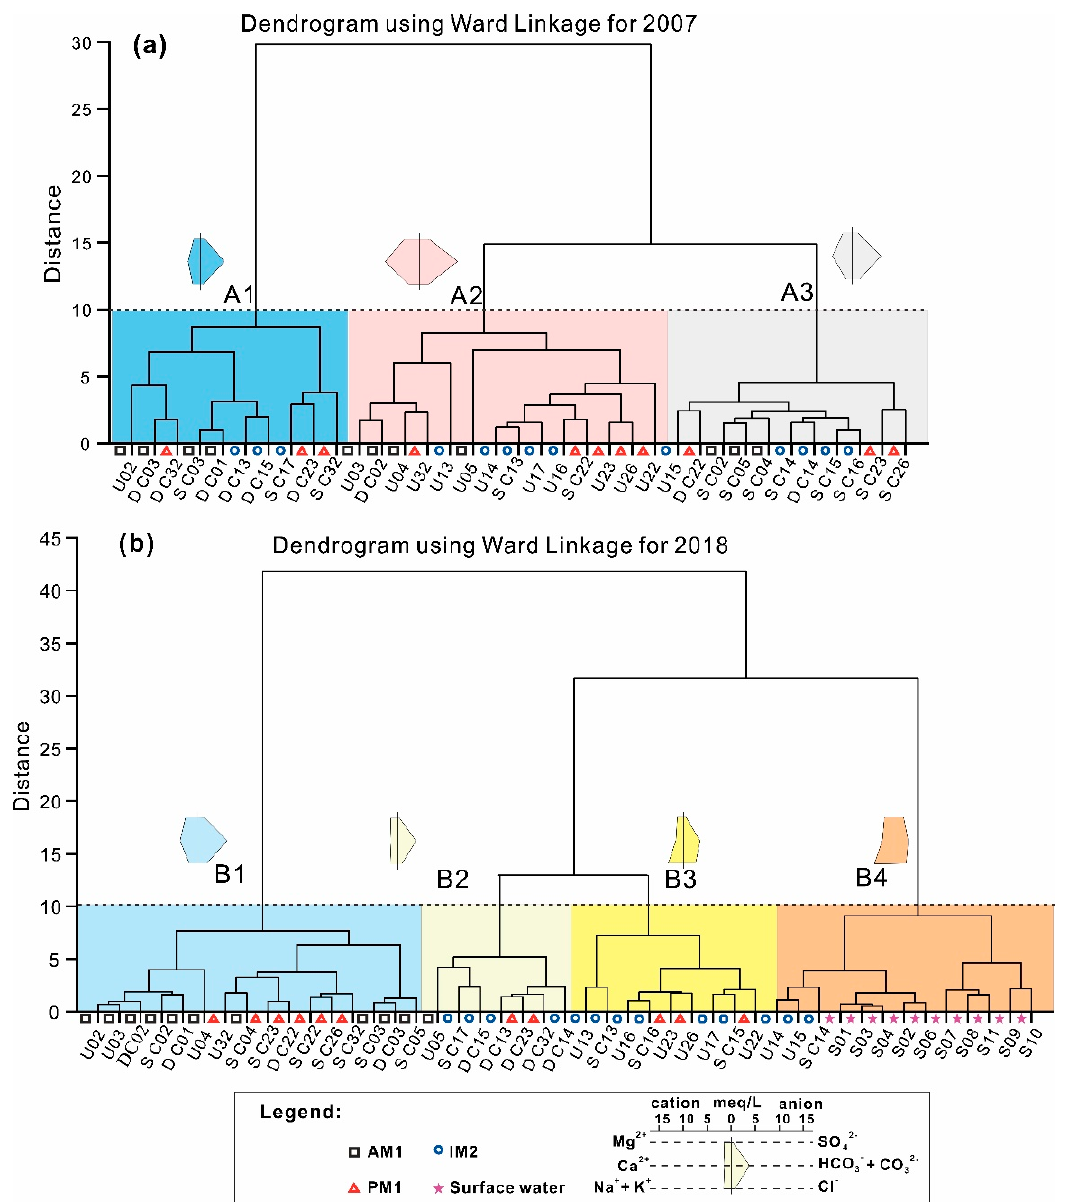
Figure 8. Diagrams for showing the HCA of hydrochemistry data collected in ( a ) September 2007 and ( b ) in May 2018. The average hydrochemical compositions of each cluster are also shown by the Stiff diagrams.